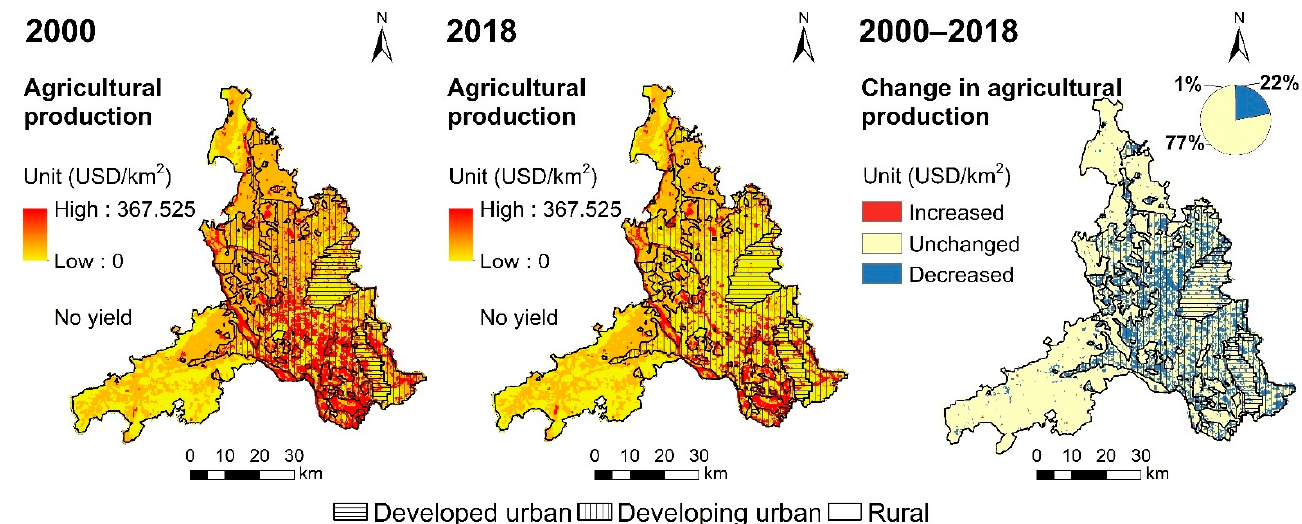
Figure 7. Spatial patterns of agricultural production in Foshan from 2000 to 2018. Table 4. Changes in ecosystem services in areas with different urbanization levels in Foshan from 2000 to 2018. Urbanization